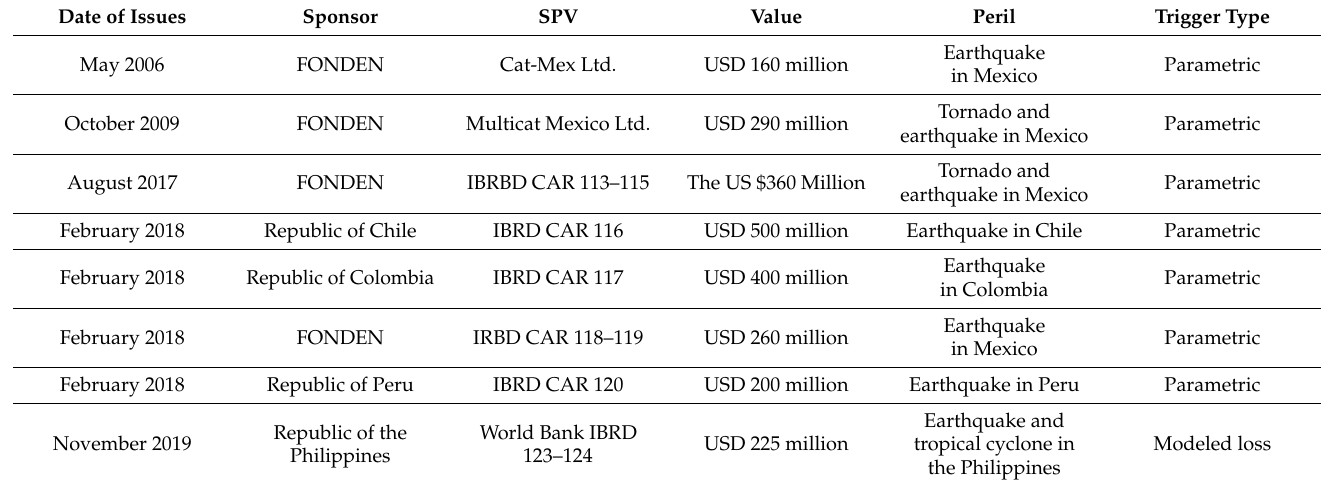
Table 1. Earthquake catastrophe bonds issued by the World